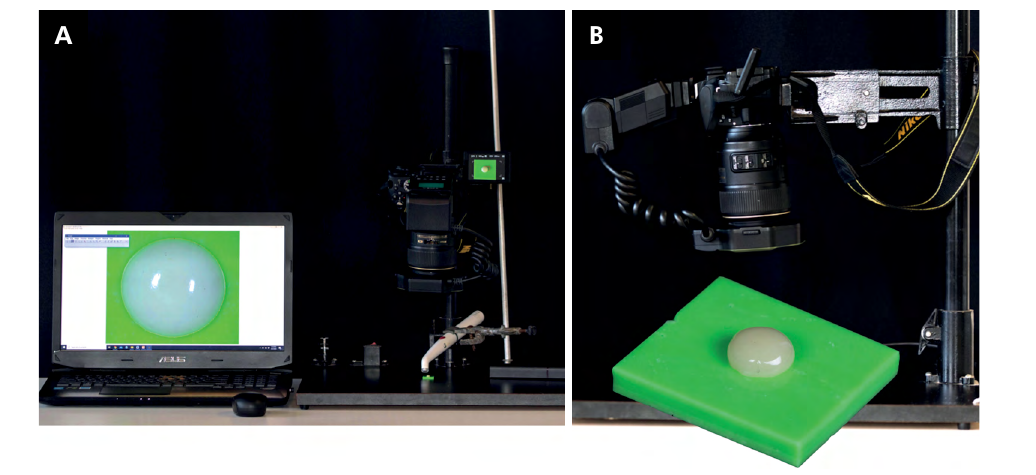
Figure 1. Experimental setup of the optical method using a DSLR camera, 105 mm macro lens and a ring flash. Frontal view (A); Side view